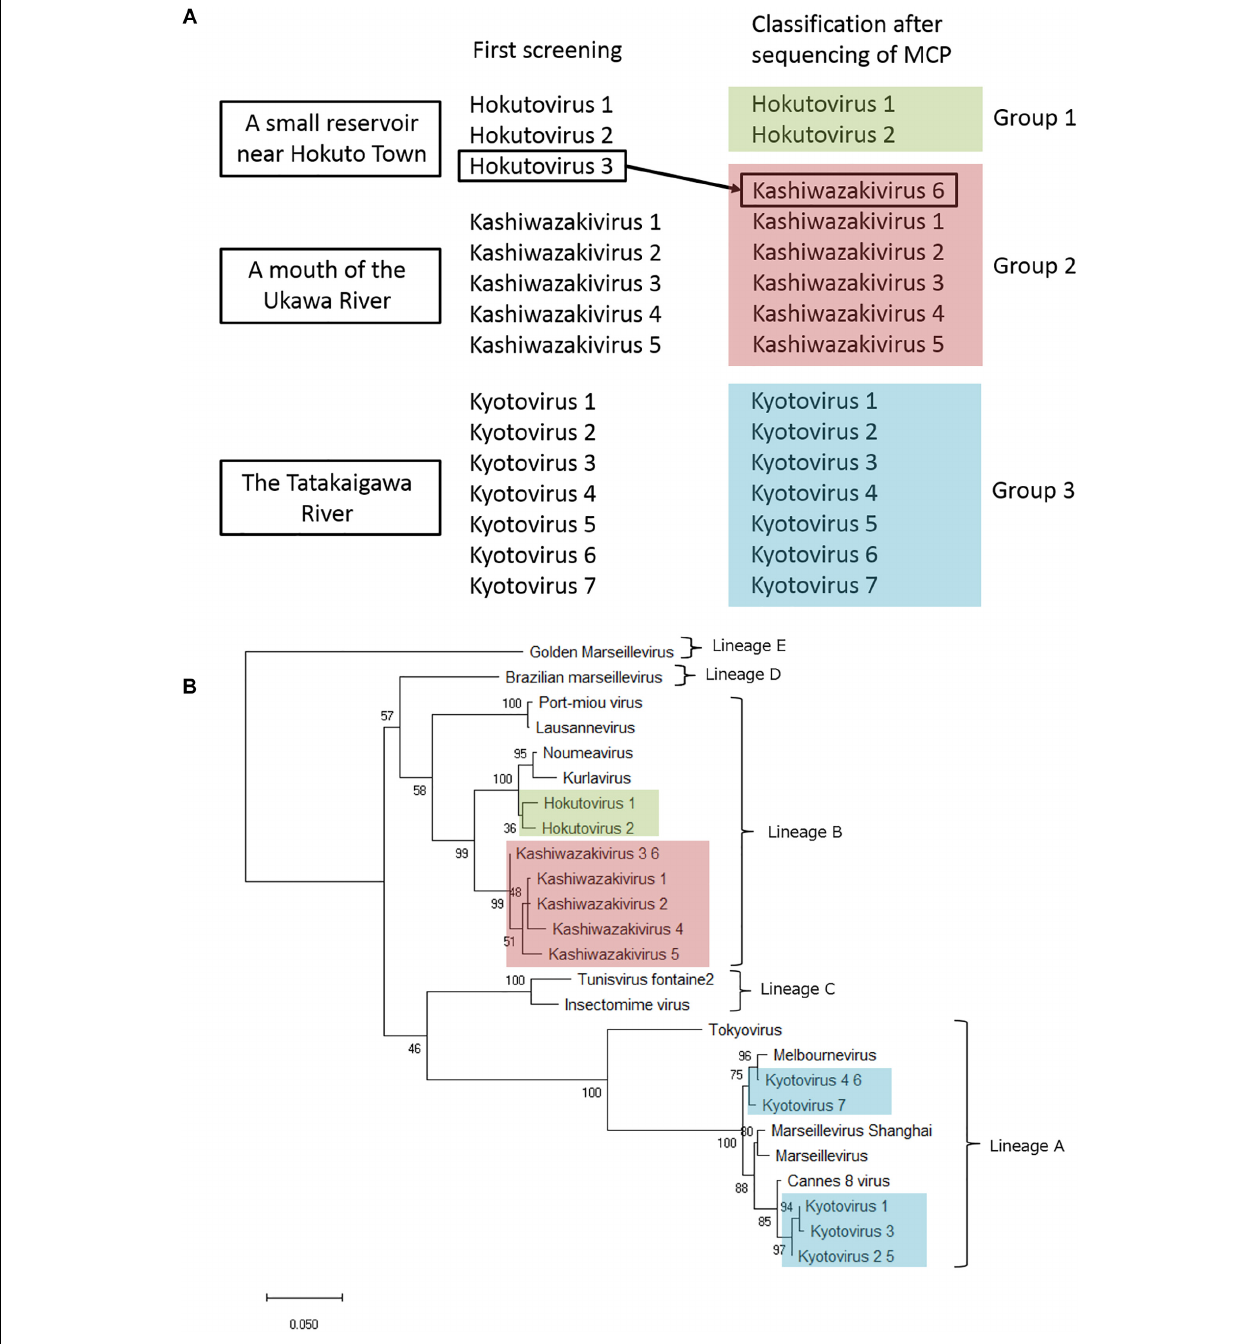
FIGURE 7 | Analysis of MCP genes. (A) Three groups of newly isolated viruses. Hokutovirus 3, which was named after first screening, was re-named to kashiwazakivirus 6 after classification according to the phylogenetic analysis of MCP gene. (B) Molecular phylogenetic analysis of MCP genes of the family Marseilleviridae . An unrooted maximum likelihood tree of MCP was reconstructed using MEGA X software. A tree was reconstructed based on MCP gene nucleotide alignment (1,429 sites) derived from the full-length alignment. Numbers at the branch points denote percent bootstrap values. Color boxes indicate newly isolated